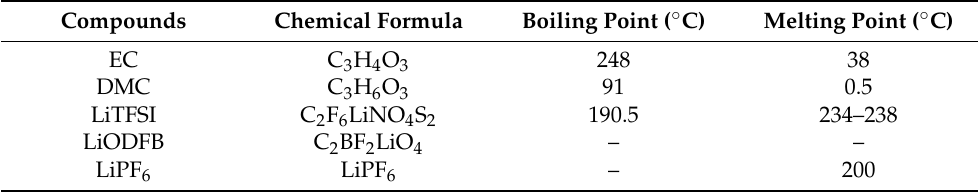
Table 1. Physico-chemical properties of electrolyte lithium salts and